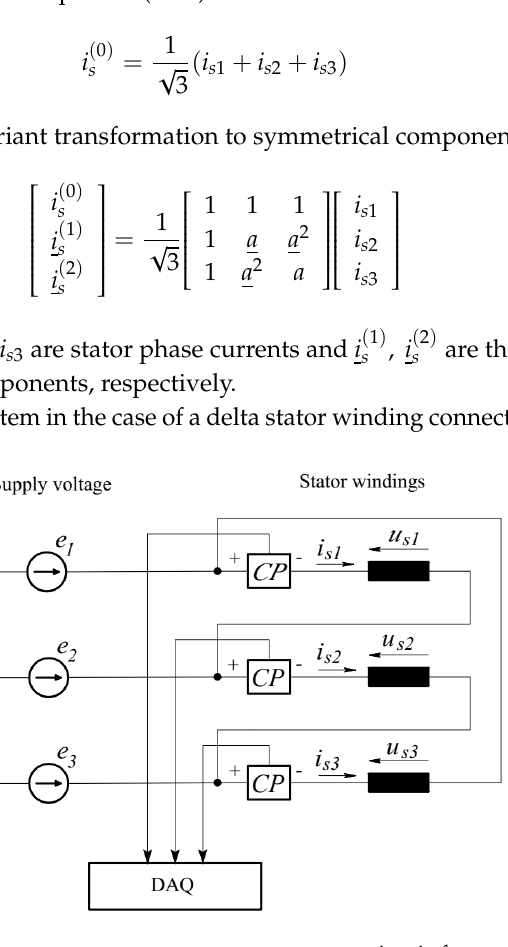
Figure 1. The zero-sequence current component measurement circuit for a machine with a delta winding connection, where e 1 , e 2 , e 3 are supply phase voltages; i s 1 , i s 2 , i s 3 are stator phase currents; u s 1 , u s 2 , u s 3 are voltages induced in stator phase windings; CP is the current probe; and DAQ is the data acquisition